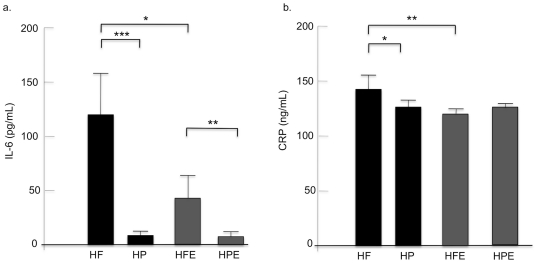
Comparison of inflammation markers between groups.Blood was collected as described in the Figure 4 legend. Interleukin-6 (IL-6) was quantified in serum samples by ELISA using a Milliplex Mouse Cytokine Panel 6-plex as described in Methods. C-reactive protein (CRP) was quantified in plasma by using a CVD CRP Single Plex kit also described in Methods. In data not shown we observed no changes in IL-1α and β, IL-10, IFN-γ, and TNF-α, by the same assays. Statistical analysis are as described for Figure 3; ***p<0.001; ** p<0.01; * p<0.05.